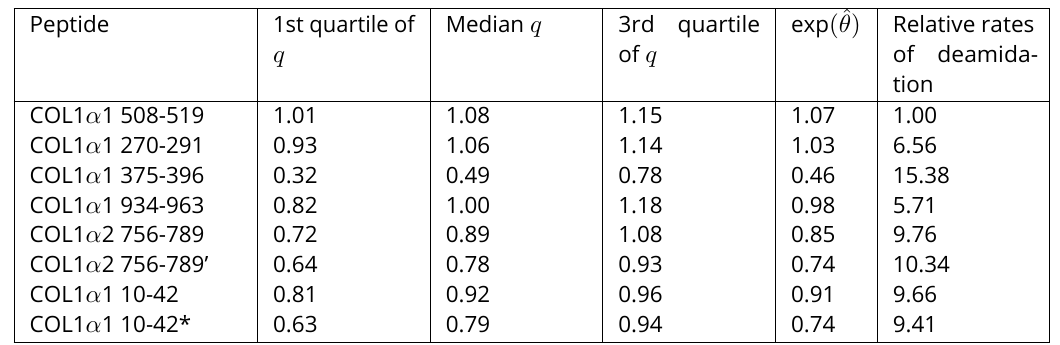
Table 3. Summary of the extent of deamidation in peptides and Restricted Maximum Likelihood estimates for fixed effects and relative rates of deamidation. Herein, q is the extent of deamidation in the peptides (from weighted least square linear regression) and exp (ˆ ✓ ) is the fixed effect estimates (from the PQI